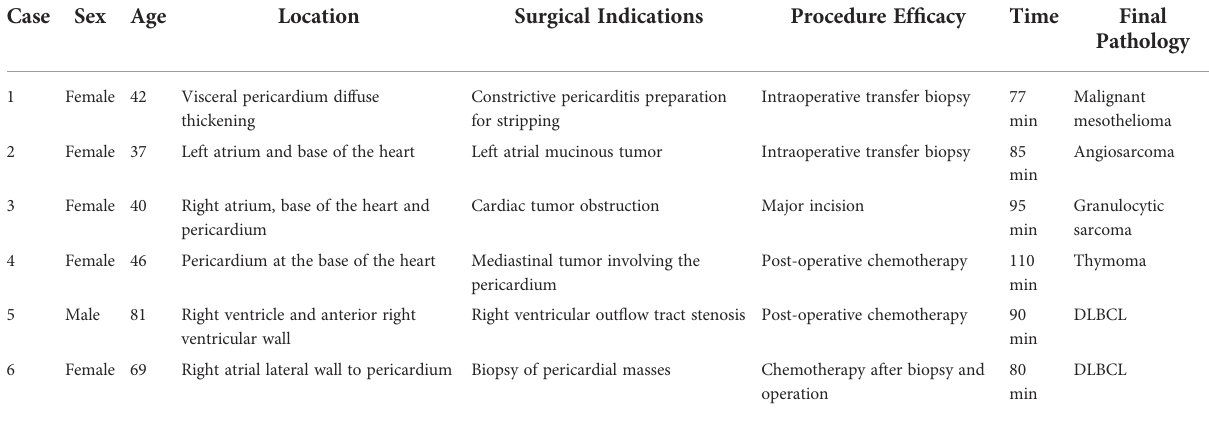
TABLE 3 Clinical information of patients treated for cardiac tumor